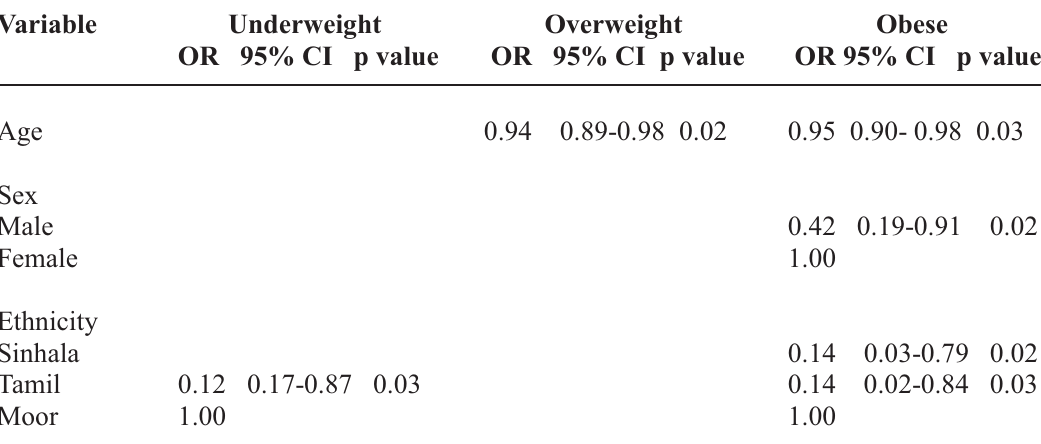
Table 3: Multinomial logistic regression for nutritional status (n=437)